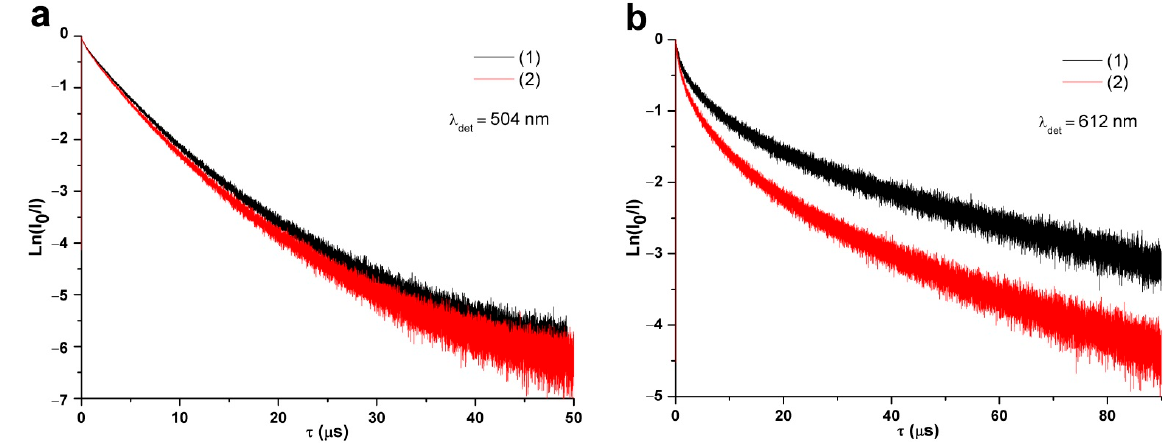
Figure 9. Extinction kinetic curves of luminescence from 3 P 0 and 1 D 2 levels of Pr 3+ ions for (ZrO 2 ) 0.805 (Y 2 O 3 ) 0.188 (Pr 2 O 3 ) 0.007 crystal, λ exc. = 450 nm, T = 300 K: ( a ) λ det. = 504 nm, ( b ) λ det. = 612 nm; (1) λ exc. = 450 nm, T = 300 K: ( a ) λ λ det. = 504 nm, ( b ) det. = 612 beginning of crystal and (2) end of crystal. (ZrO 2 ) 0.805 (Y 2 O 3 ) 0.188 (Pr 2 O 3 ) 0.007 crystal,